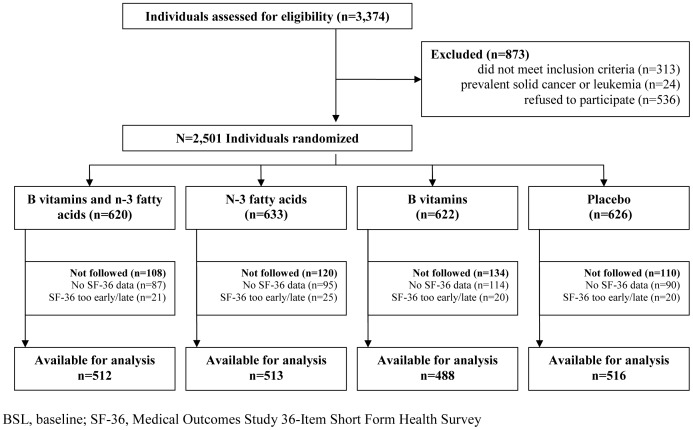
Flow chart of the study participants.